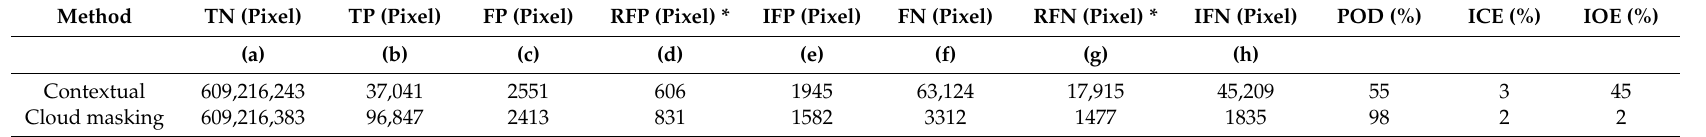
Table A1. Statistical comparison of ToPeCAl-2 to ToPeCAl-1 applied to Landsat-8 images data based on contextual test and cloud masking approach. The comparison was for one class of fire and ToPeCAl-1 was the reference fire data. Column a to h are the summation values from 15 datasets of Landsat-8. False positive and false negative pixels consisted of fires spatially related to true positive fires—called related false positive / negative (RFP / RFN) and independent false positive / negative (IFP / IFN) pixels. The RFP pixels were the fire pixels that were adjacent to the true positive fire pixels within a one pixel outer bu ff er; they were considered not to be counted as commission errors calculation and can be classified as true positive pixels. Likewise, the RFN pixels for omission error. (TN = True Negative; TP = True Positive; FP = False Positive; RFP = Related False Positive; IFP = Independent False Positive; FN = False Negative; RFN = Related False Negative; IFN = Independent False Negative; POD = Probability of Detection, ICE = Independent Commission Error, IOE = Independent Omission Error). Method